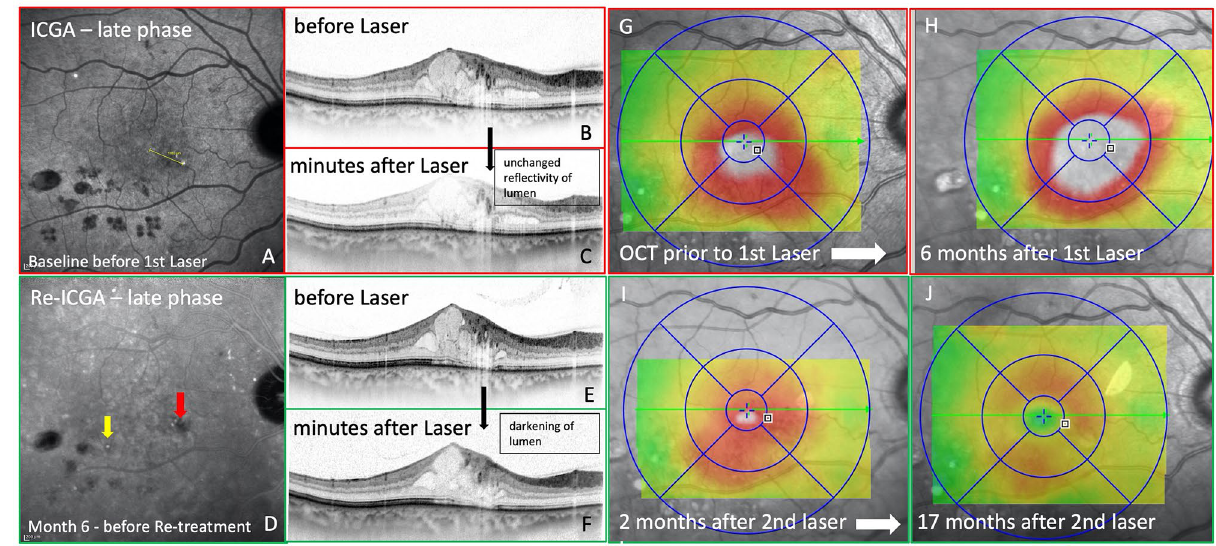
Figure 4. Multimodal imaging of a patient with diabetic macular edema pretreated with anti-VEGF and fluorescein angiography (FA)-based focal/grid laser. Late-phase indocyanine green angiography (ICGA) performed at baseline reveals the presence of two teleangiectatic capillaries (TC) nasally from the fovea ( A ) in near proximity to the peak of the edema ( G ). High resolution OCT single line scans leading right through the center of the larger TC show hyporeflectivity of its lumen, compared to the surrounding vessel wall ( B ). Minutes after the first laser session no change in the TCs lumen was detected ( C ). Consequently, 6 months after laser therapy the TC was still present without a tendency for either shrinking or resolution ( E ). Within the first 6 months after laser therapy the extent of the edema increased ( H ). Therefore, ICGA was repeated, with poor visualization of the TC that was initially targeted with laser, due to partial blocking of the ICG signal by an overlying spot bleeding ( D ; red arrow). However, the OCT scan clearly shows, that the TC is still present ( E ). During the second laser session, a darkening of the TCs lumen was observed with OCT ( F ). Consequently, a marked reduction of the edema was seen as early as 2 months after laser therapy ( I ). 17 months after re-treatment with ICGA-guided focal laser coagulation only little parafoveal retinal swelling remained without central involvement of the edema. ( J ) No additional treatment with anti-VEGF was needed in this patient. Visual acuity increased from 20/32 Snellen visual acuity at baseline to 20/20 23 months after the intial laser therapy with no need for any anti-VEGF